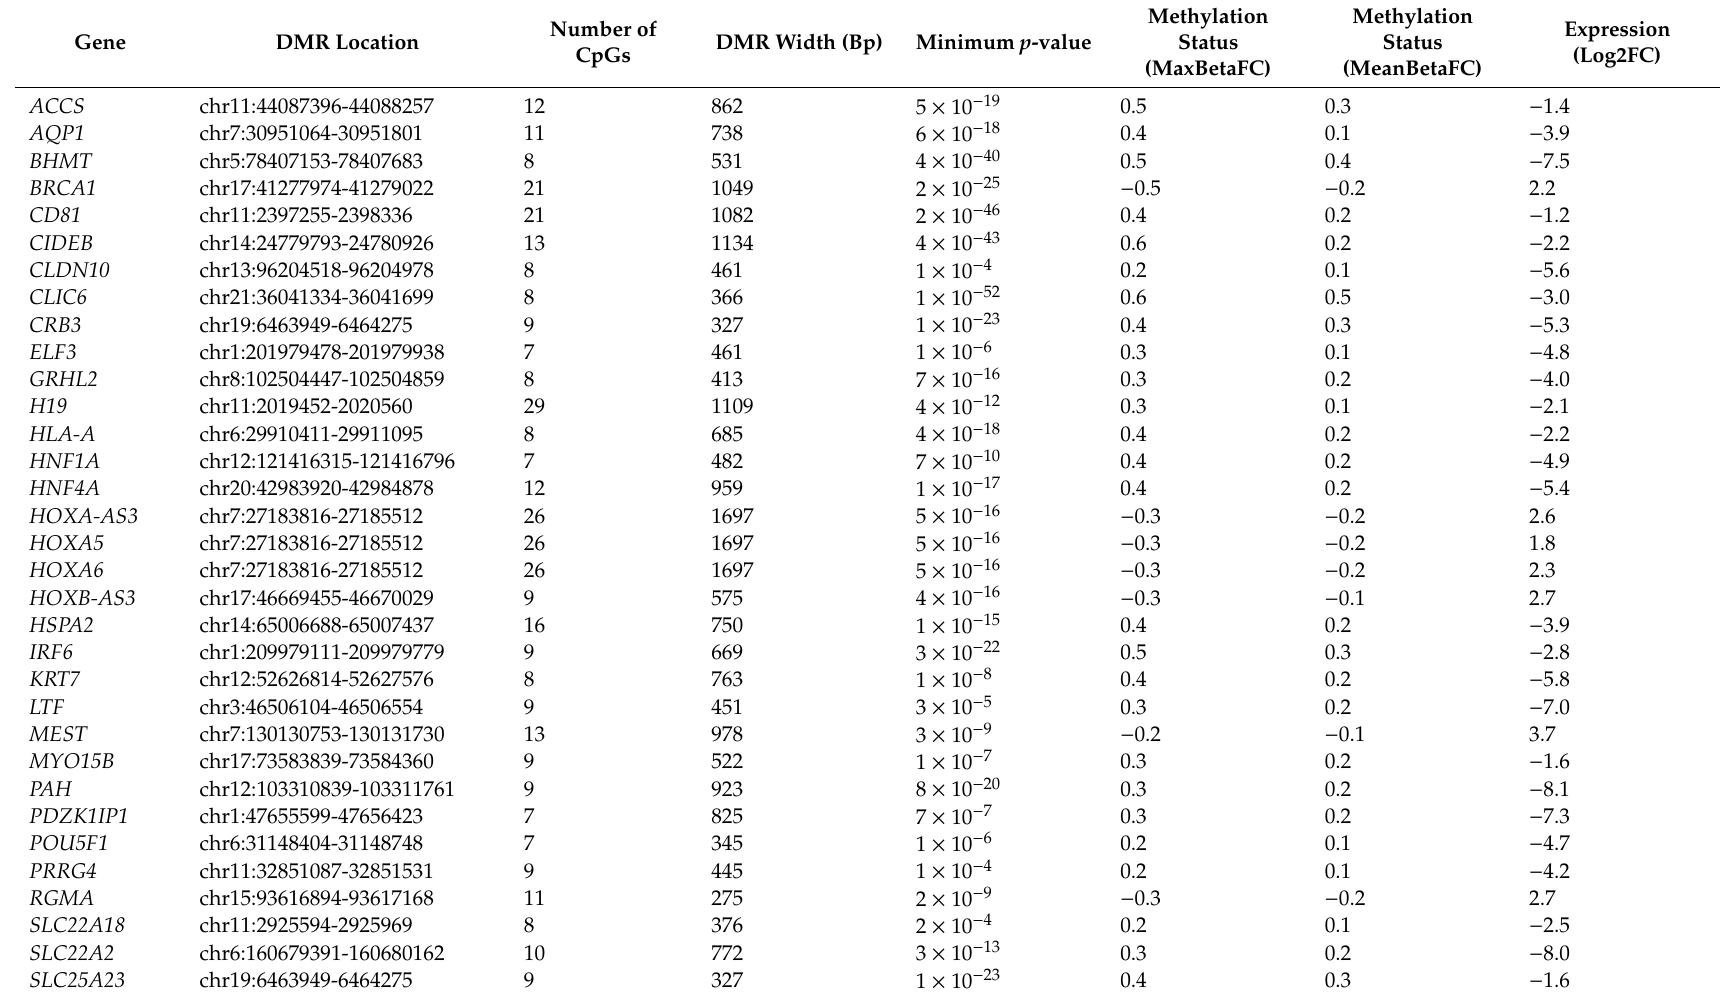
Table 2. List of 44 genes showing negative correlation between promoter methylation and gene expression